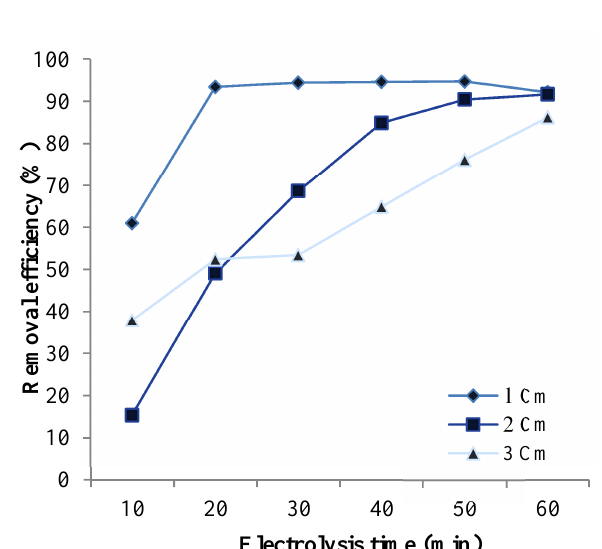
Figure 9. Effect of distance between electrodes on removal efficiency of Reactive Green 19 (RG-19) dye (Voltage = 50 v, C 0 = 50 mg/l, KCl = 0.01 M, pH = 11, T = 22 ± 2 º C)